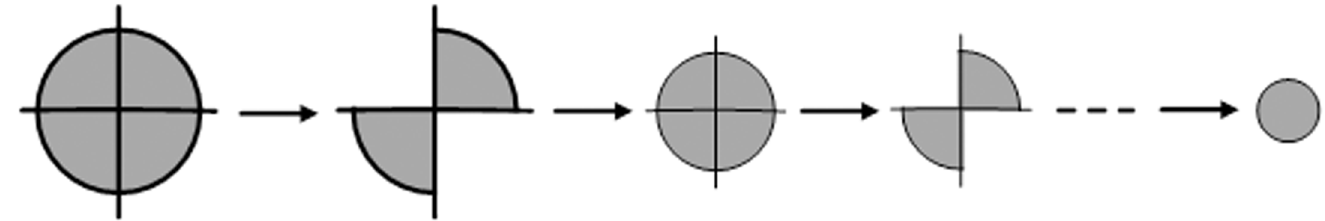
Fig 2. Schema of